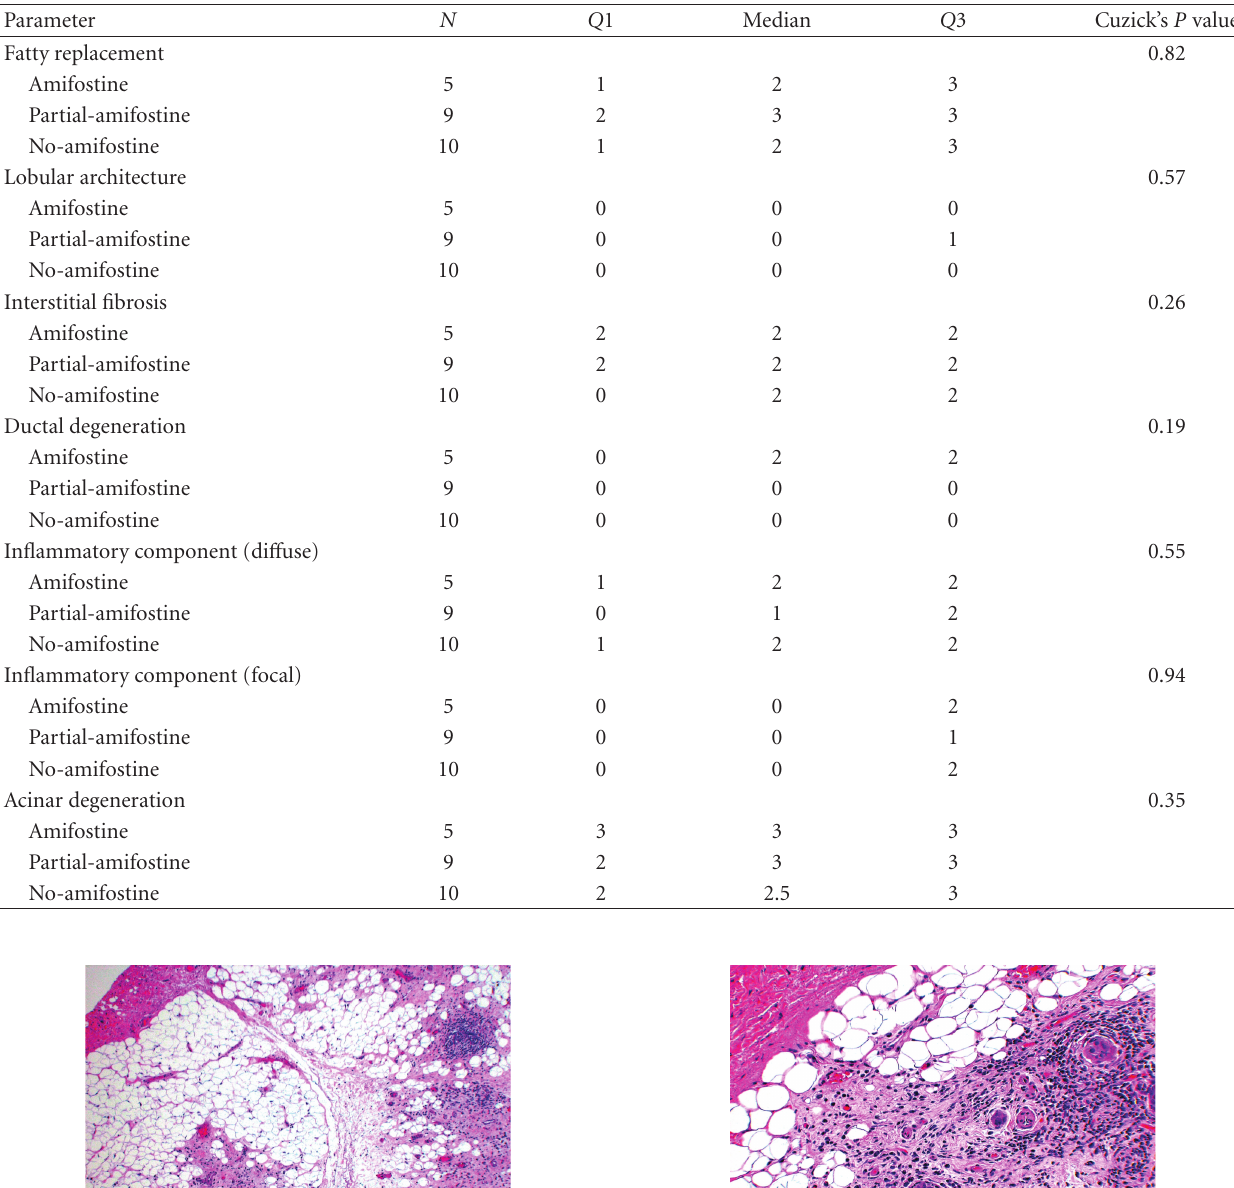
Table 3: Histological variable analysis.